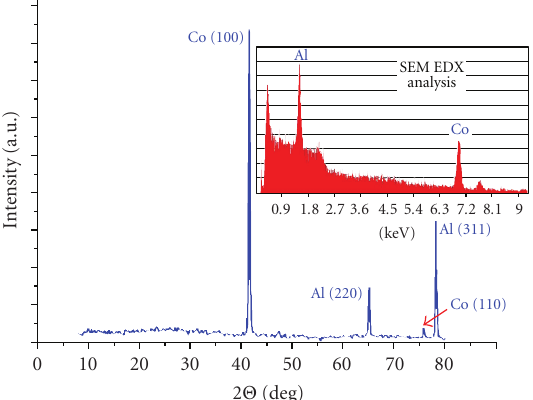
Figure 8: Typical X-ray di ff raction spectrum for a Co nws array fabricated inside the oxalic acid alumina pores by DC deposition under the same galvanostatic conditions as in Figure